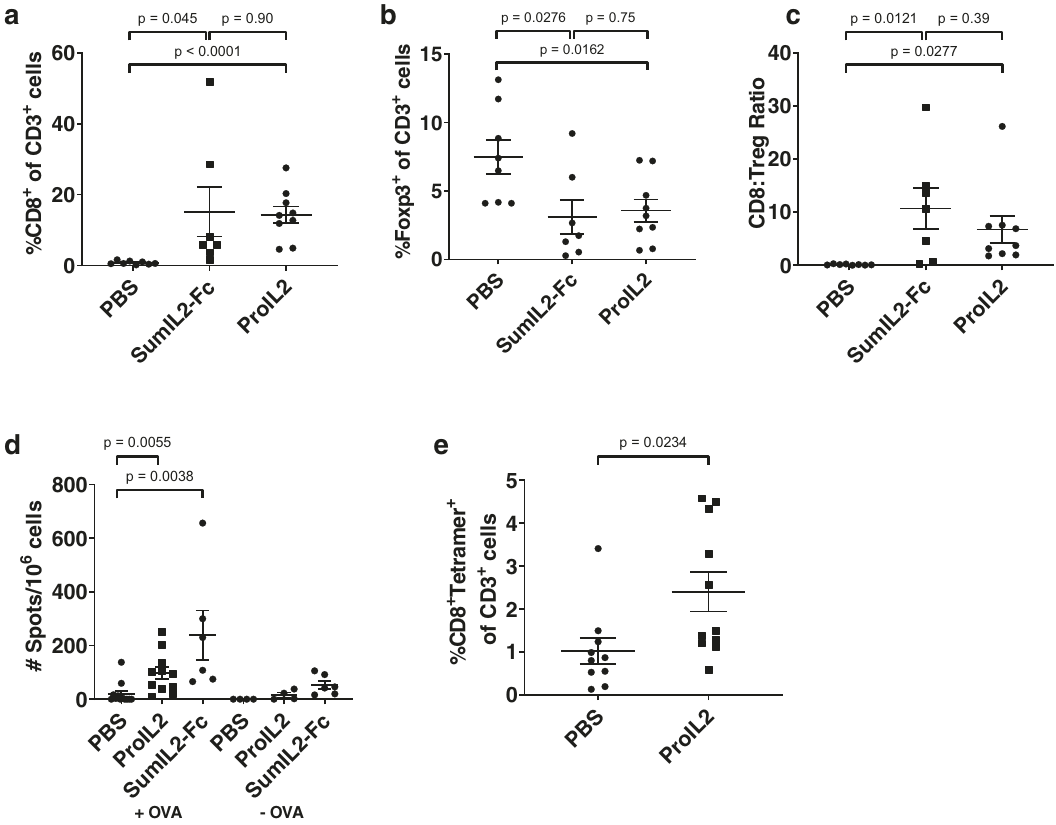
Fig. 5 In vivo fl ow cytometry analysis of ProIL2. a – c B16 s.c. tumor-bearing mice were injected i.p. with PBS, SumIL2-Fc or ProIL2 (300 pmol) two times on days 9 and 12 post tumor inoculation. 48 h after the last treatment, mice were euthanized and tumors were extracted, digested in collagenase/DNAse, and resuspended as single cells. Flow cytometry was used to quantify the amount of CD8 T cells, amount of Tregs, and CD8:Treg ratio in each respective group ( n = 2 experiments, total 8 individual mice for PBS treatment group, 7 for SumIL2-Fc, 9 for ProIL2). d B16-OVA s.c. tumor-bearing mice were injected i.p. with PBS or ProIL2 (300 pmol) one time on day 9 post tumor inoculation. 5 days after treatment, draining lymph nodes were collected, IFN γ ELISPOT analysis was performed and spots were quanti fi ed ( n = 2 experiments, total 12 individual mice for PBS/OVA group, 11 for ProIL2/OVA, 6 for SumIL2-Fc/ OVA, 4 for PBS/no OVA, 4 for ProIL2/no OVA, 6 for SumIL2-Fc/no OVA). e B16-OVA s.c. tumor-bearing mice were injected i.p. with PBS or ProIL2 (300 pmol) one time on day 9 post tumor inoculation. 5 days after treatment, mice were euthanized and tumors were extracted, digested in collagenase/DNAse, and resuspended as single cells. Flow cytometry was used to quantify the amount of OVA-tetramer CD8 T cells ( n = 3 experiments, total 10 individual mice for PBS treatment group, 11 for ProIL2). Data represent mean ± s.e.m. Student ’ s t tests were performed to calculate p values. Source data are provided as a Source Data fi